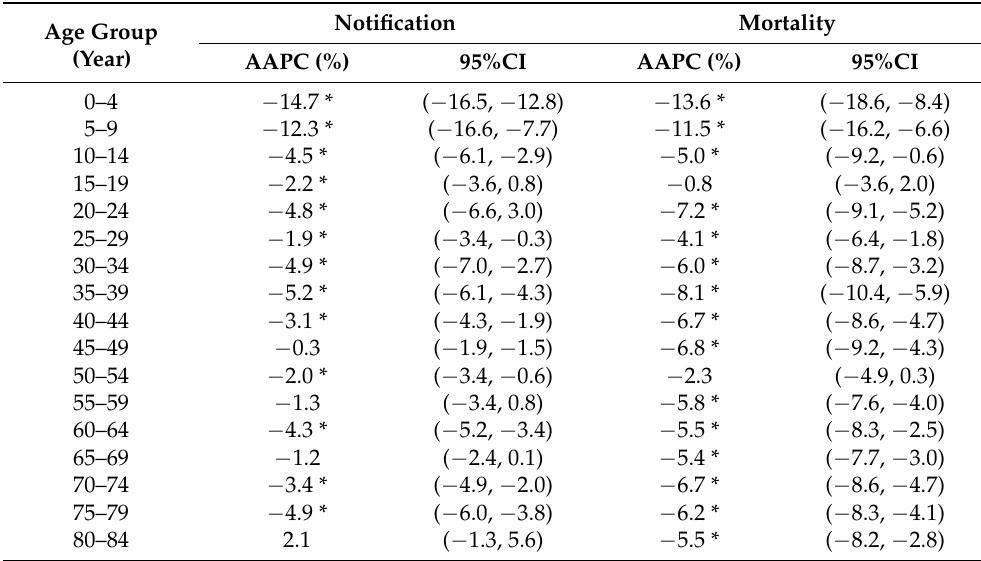
Table 1. Age-specific TB incidence and mortality variation with time (per 100,000),